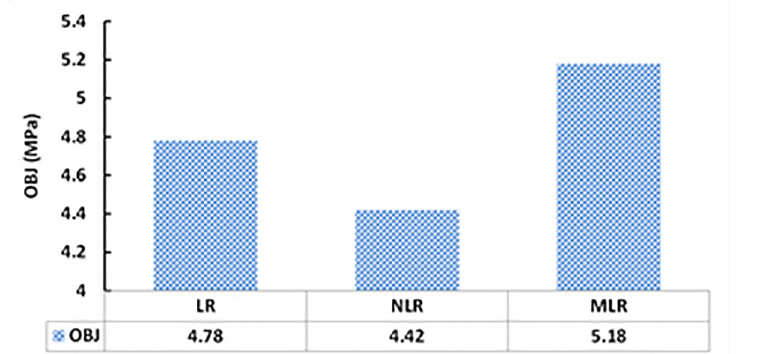
Fig 16. The OBJ values of all developed